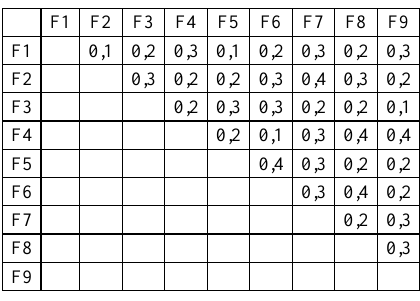
Table 4. Remoteness function value among the